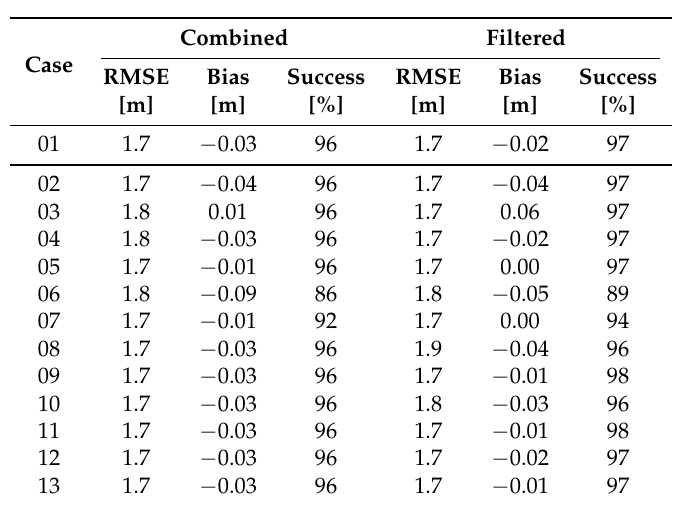
Table 4. Sensitivity of the global actual RMSE and bias (in pixels), together with the percentage of success, of the combined shorelines and the filtered shorelines to the parameter values described in Table 2, using a threshold for the self-computed errors of 20 px and including all studied dates and